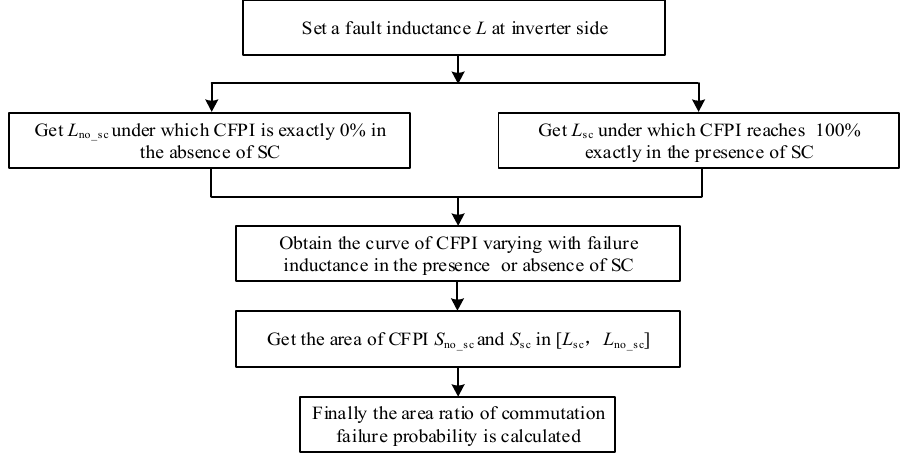
Figure 5. Flow-chart of the area ratio of the commutation failure probability computing method.